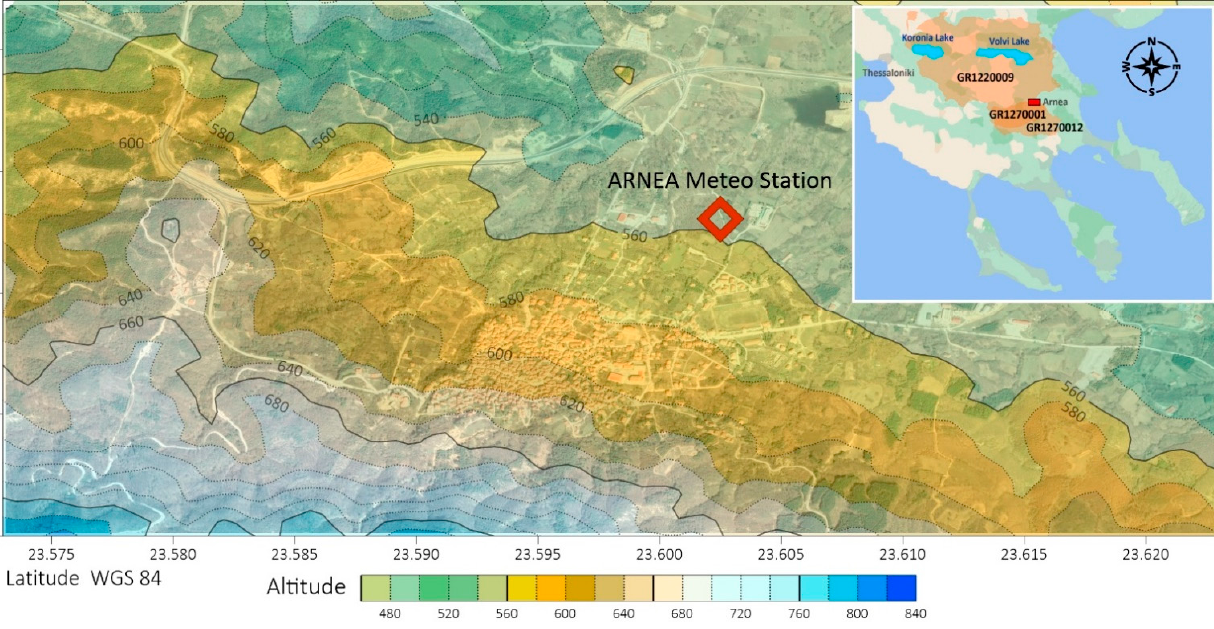
Figure 1. Geophysical map of the Arnea’s meteorological station and broader area (Chalkidiki, N. Greece), also depicting the expansion of the Natura 2000 protected sites (SPA GR1220009, SPA GR1270012 and SCI GR1270001).